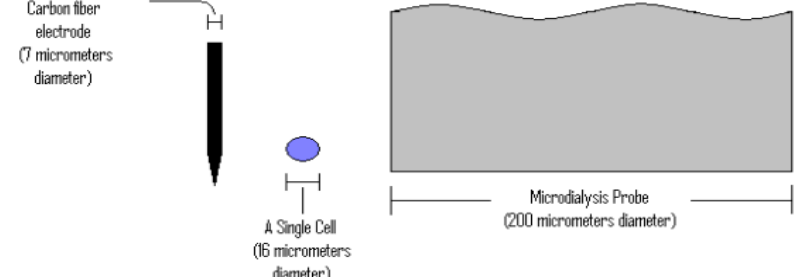
Figure 14. The relative sizes of a carbon fiber electrode and a microdialysis probe next to a single cell.